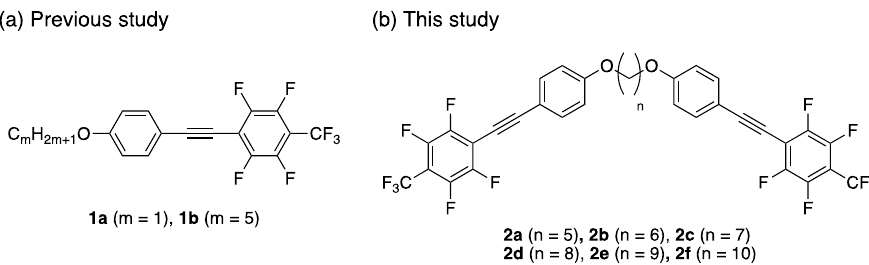
Figure 1. ( a ) Solid-state photoluminescent molecules 1 containing fluorinated aromatic structures developed in our group and ( b ) molecular structure for new solid-state photoluminescent molecules 2 designed in this study.